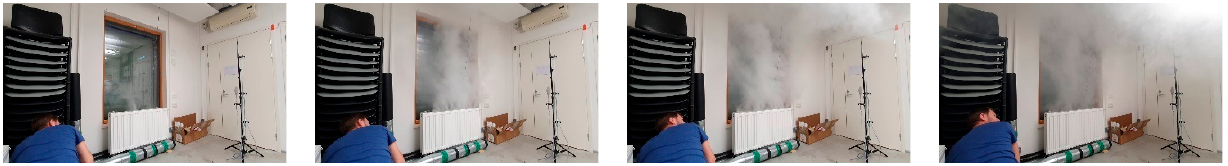
Figure 17. Air circulation pattern of radiators HIGH. Periodic snapshots every 5 s.